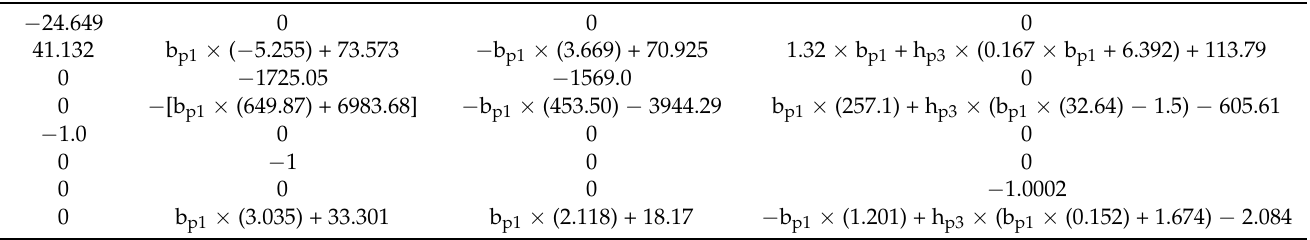
Table A1. The functional relations of 1–4 Column elements of matrix A with respect to h p3 and b p1 .